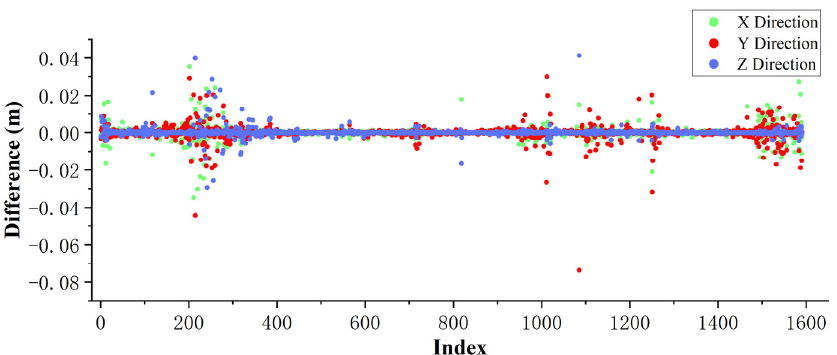
Figure 17. Positioning result difference of using the Bursa model and rotation matrix model.